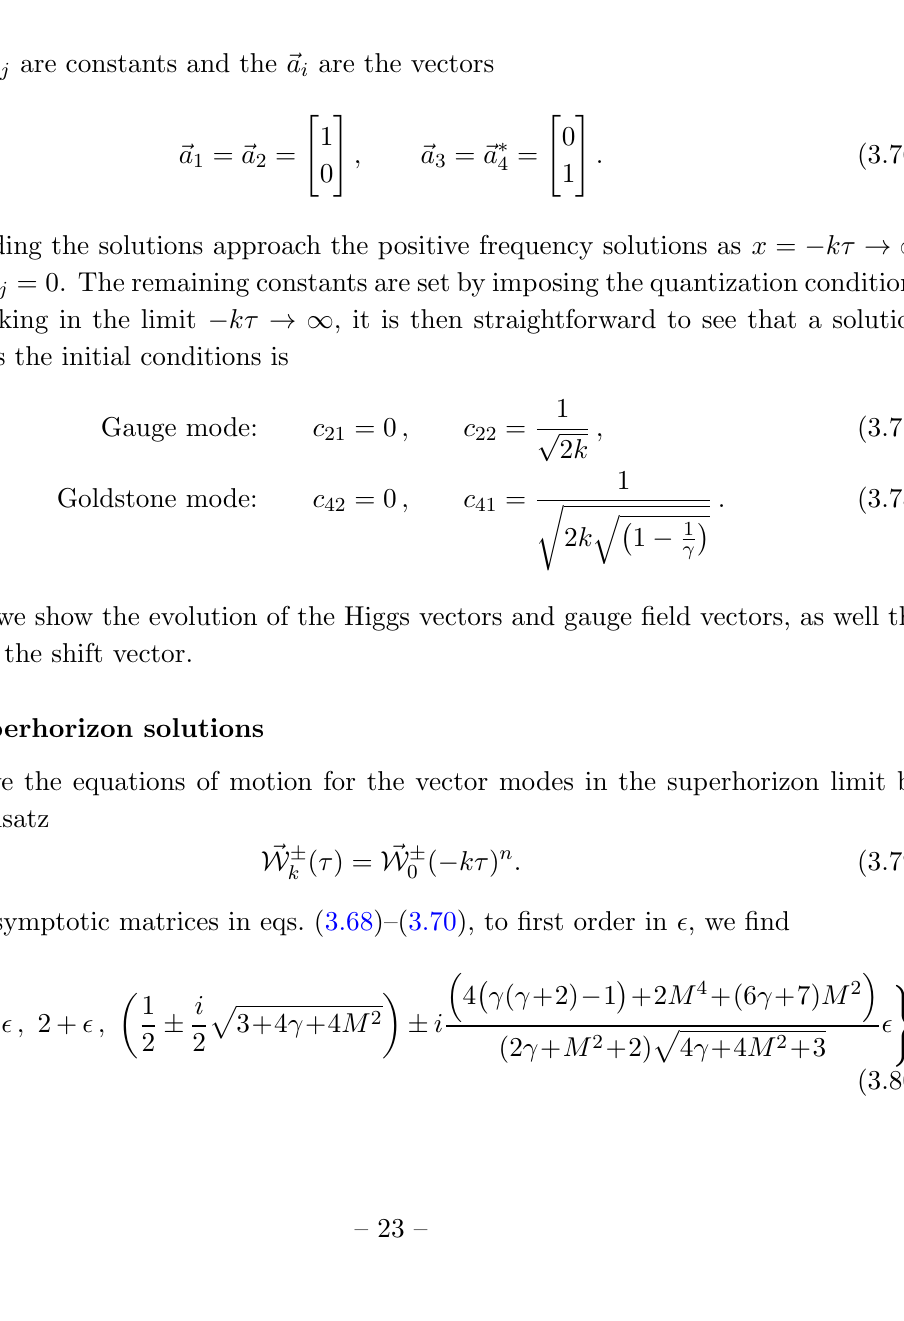
Figure 6 . Evolution of vector (cid:13)uctuations in Higgsed Gauge-(cid:13)ation. Note that in the limit M ! 0, the vector modes all decay on superhorizon scales. The values of the other parameters here are p chosen to be (cid:15) = 0 : 01 and (cid:13) =